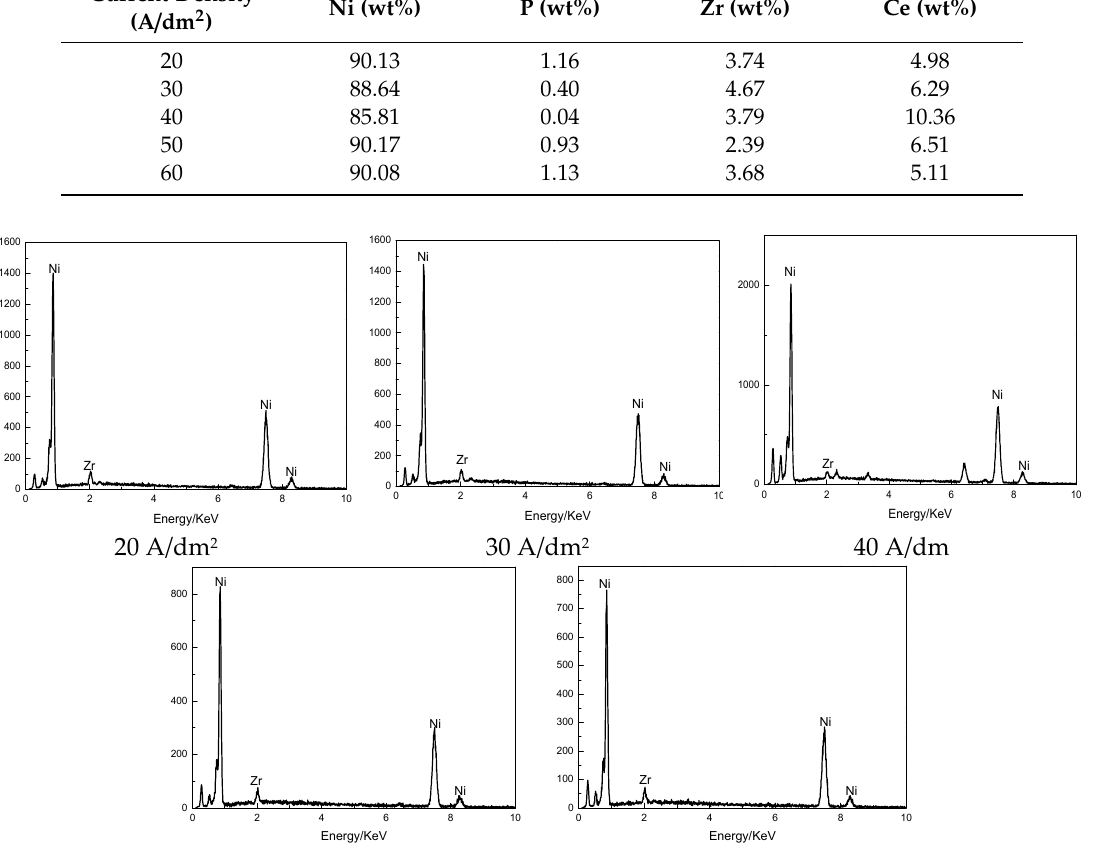
Table 3. Mass fraction of elements on the coating su rface at different current densities.